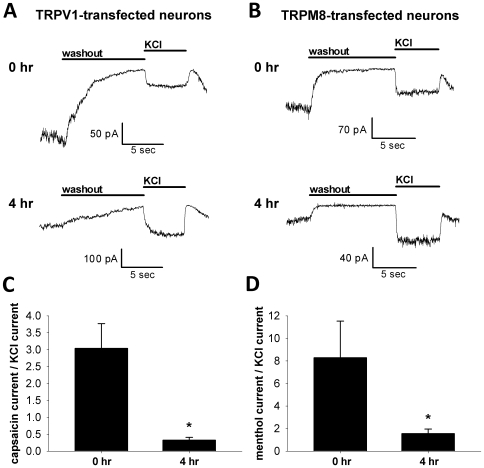
Agonist-induced currents in both TRPV1- and TRPM8-transfected neurons are decreased after prolonged exposure.(A) Examples of TRPV1-transfected neurons exposed to bath application of 500 nM capsaicin, 25 µM D-APV, and 1 µM NBQX acutely (top panel) or for 4 hr (bottom panel) prior to recording in whole-cell voltage clamp. Capsaicin was retained in the bath recording solution. After the whole-cell recording was established, capsaicin was briefly removed by perfusing fresh recording saline for 10 s before 5 s application of 30 mM KCl. (B) Examples of TRPM8-transfected neurons exposed to bath application of 100 µM menthol, 25 µM D-APV, and 1 µM NBQX acutely (top panel) or for 4 hr (bottom panel) prior to recording in whole-cell voltage clamp. Similar to (A), menthol was added to the bath recording solution. Menthol was removed by perfusing fresh, menthol-free recording saline for 10 s before 5 s application of 30 mM KCl. (C) The average ratio of capsaicin current amplitude to KCl current amplitude was calculated for acute and 4 hr applications of capsaicin. Error bars represent SEM. The ratio of capsaicin to KCl current is significantly decreased after 4 hr capsaicin exposure (Student's unpaired t test, p<0.05). (D) Similar to C except the ratio of menthol to KCl currents in TRPM8-transfected neurons is depicted. Error bars represent SEM, and the menthol to KCl current ratio is significantly decreased after 4 hr exposure to menthol (Student's unpaired t test, p<0.05).